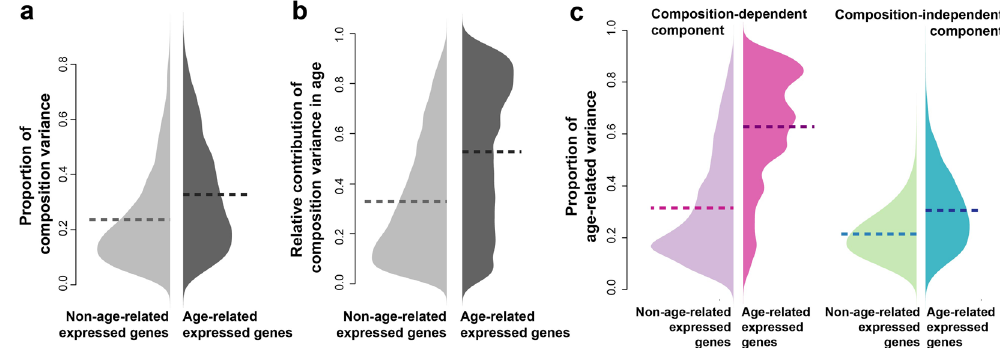
Figure 3. The cell type composition change was the primary driving force of the age-related expression. ( a ) The proportion of gene expression variance explained by cell type composition (composition-related variance) in the human postnatal brain data set. Light grey – genes without age-related expression; dark grey – genes with age-related expression. The horizontal dash lines show the mean proportion of composition-related variance. ( b ) The relative contribution of the composition-dependent component to the variance explained by age (age-explained variance), measured as ratio of age-explained variance in the composition-dependent component to the sum of age-explained variance in both components. Light grey – genes without age-related expression; dark grey – genes with age-related expression. The horizontal dash lines show the mean proportion of composition-related variance. ( c ) The proportion of variance explained by ages (age-related variance) in each of the two components of expression: pink – the composition-dependent component; green – the composition- independent component. The light colors represent the proportions of age-related variance in genes without age-related expression changes; the dark colors represent the proportions of age-related variance in genes with age-related expression changes. The horizontal dash lines show the means of age-related variance